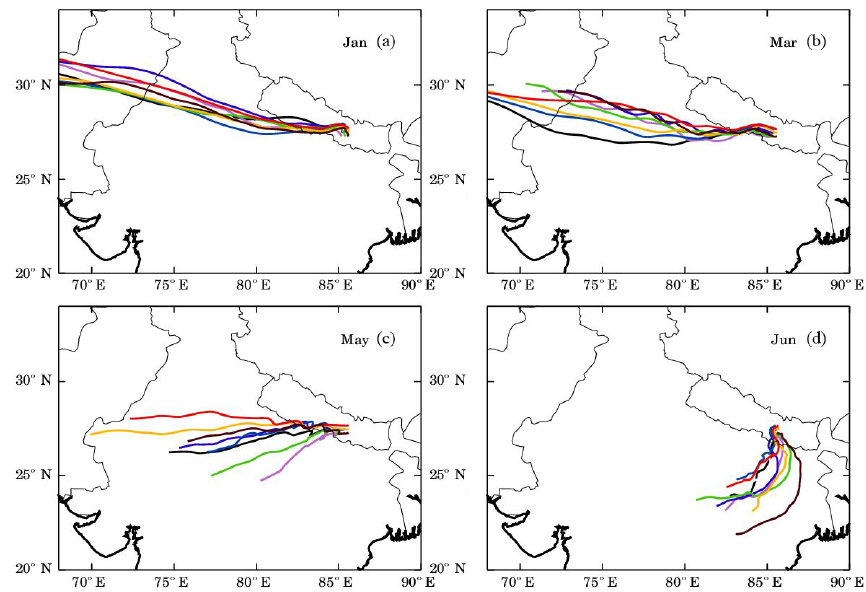
Figure 4. The 5-day nine-point HYSPLIT backward air trajectories over the Bode region during (a) January, (b) March, (c) May and (d) June. The colored trajectories are monthly averaged for each particle during the respective